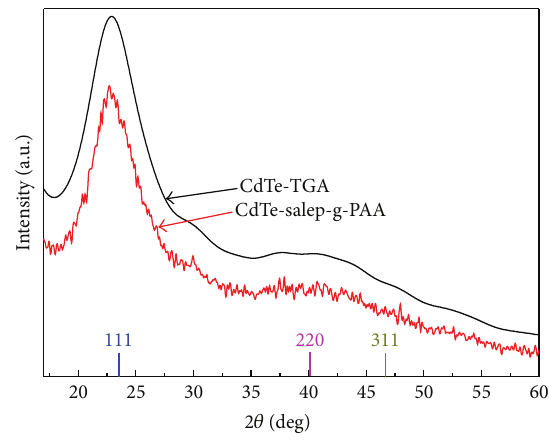
Figure 6: XRD patterns of CdTe-salep-g-PAA